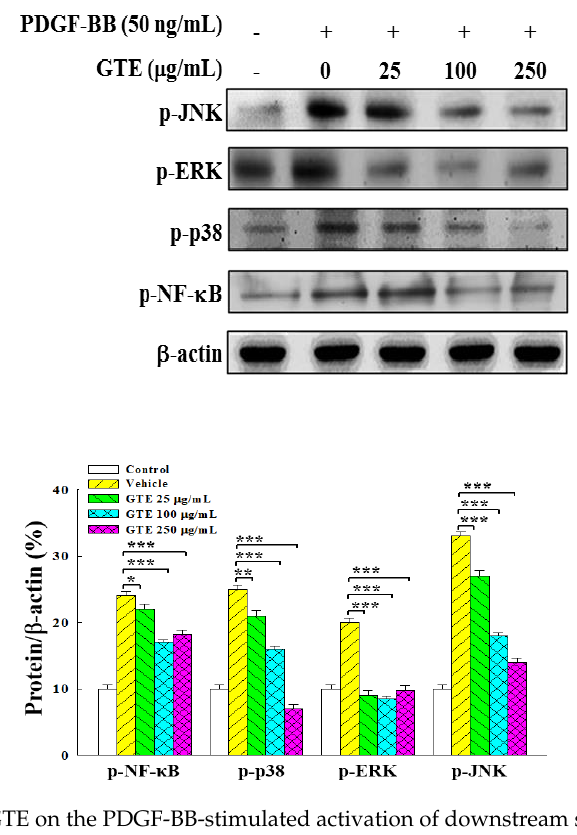
Figure 4. Effects of GTE on the PDGF-BB-stimulated activation of downstream signaling pathways in VSMCs. PDGF-BB-stimulated VSMCs were treated with 0–250 μg/mL of GTE for 48 h. The cell